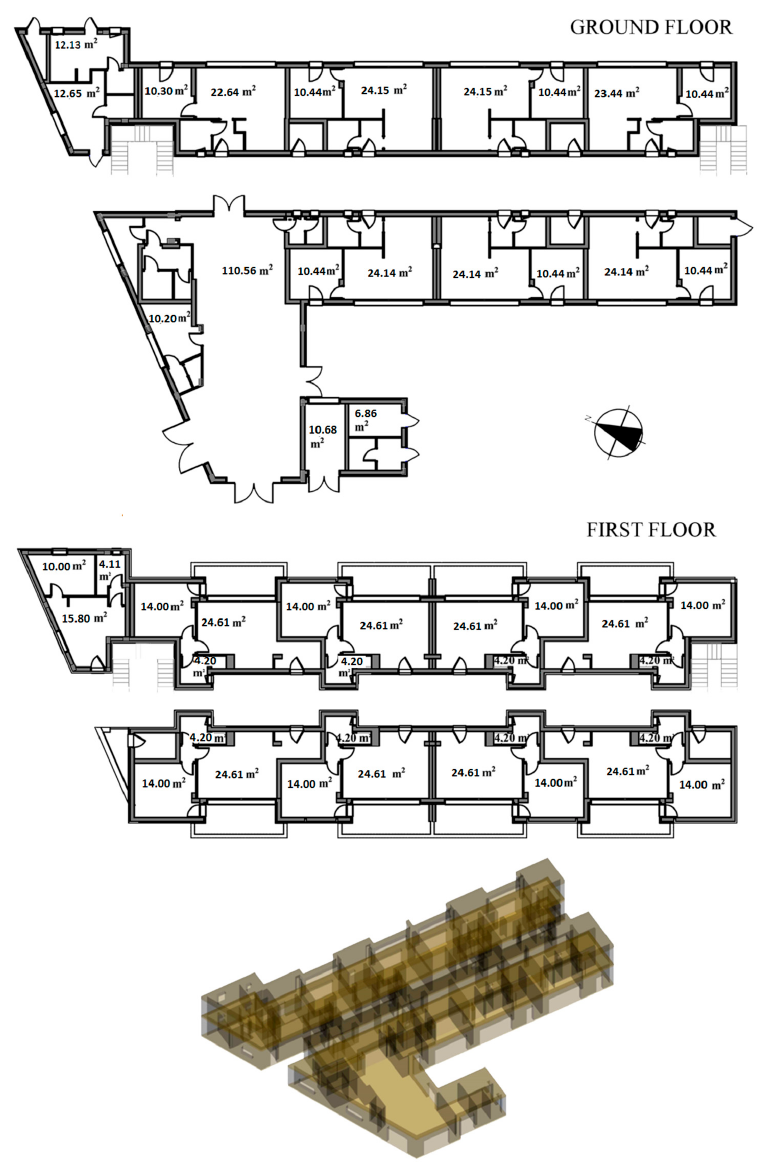
Figure 1. Geometrical features and 3D view of the reference building.